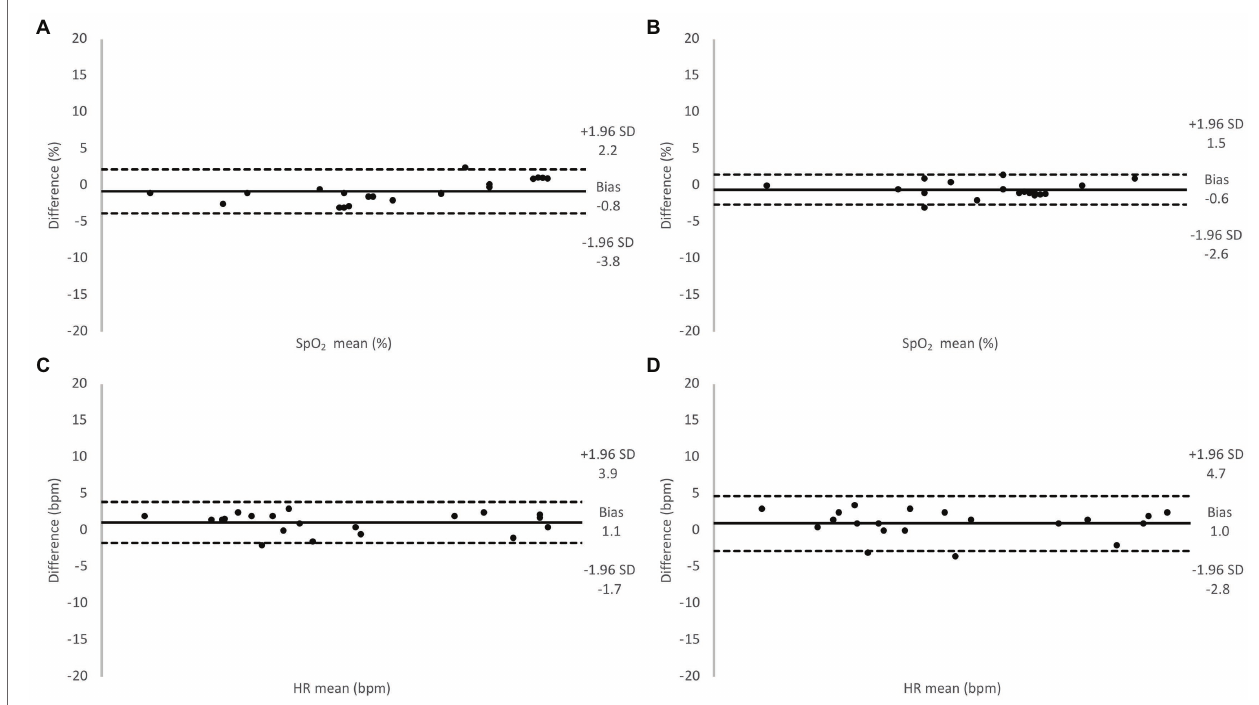
FIGURE 5 | Relative difference between oxygen saturation (SpO 2 ) values measured using the Masimo pulse oximeter and the SUB pulse oximeter (A) , the Lifesense pulse oximeter and the SUB pulse oximeter (B) , and for HR values measured using the Masimo pulse oximeter and the SUB pulse oximeter (C) , the Lifesense pulse oximeter and the SUB pulse oximeter (D) , under normoxic